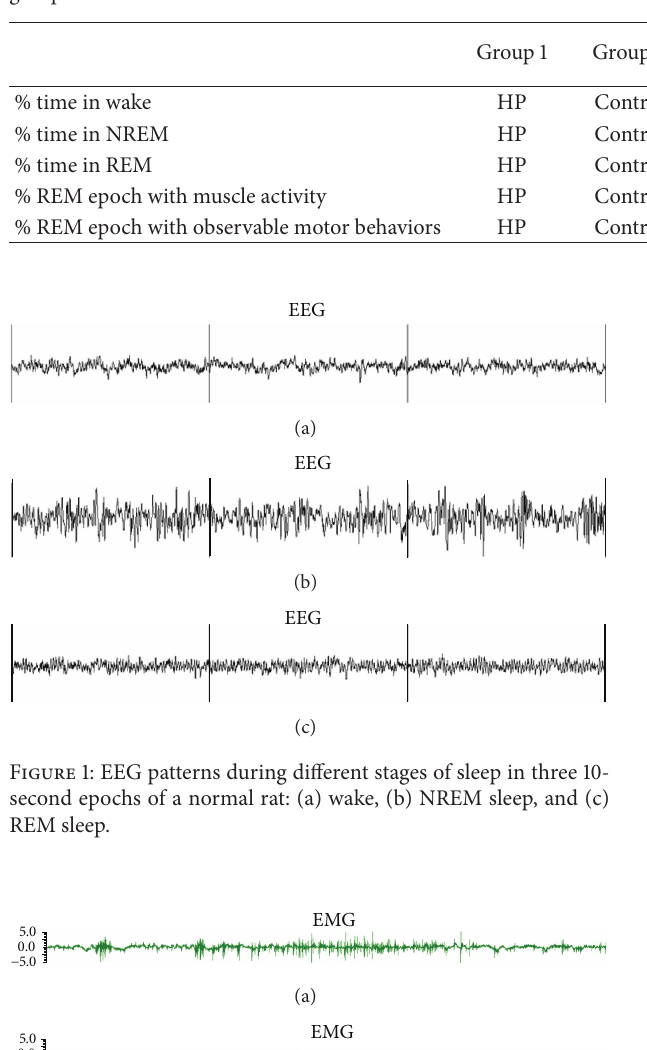
Table 1: Comparison of mean differences of percentage of time spent in wake-sleep stages (wake, NREM, and REM), percentage of REM epochs with muscle activity, and percentage of REM epochs with observable motor activity between control and hemiparkinsonian (HD) groups.